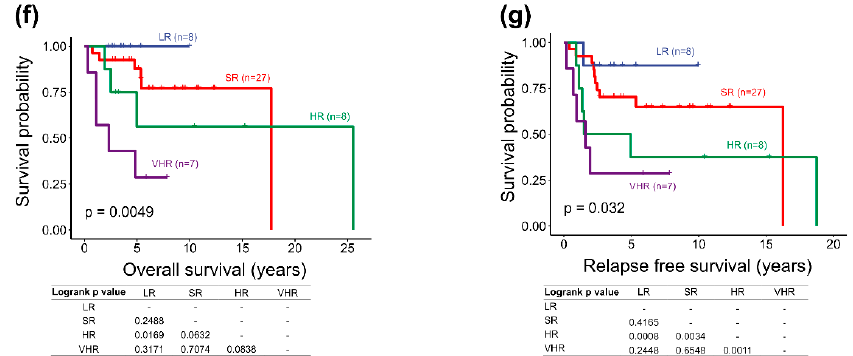
Figure 1. Outcome analysis of 52 childhood Medulloblastomas (MBs) in a cohort series in Taiwan. ( a ) Outcome analysis split based on overall survival (OS) (red) and relapse-free survival (RFS) (blue). ( b , c ) OS and RFS split into four core molecular subgroups: blue, WNT MB; green, Group 4 MB; red, SHH MB; yellow, Group 3 MB. ( b ) OS. ( c ) RFS). ( d , e ) OS and RFS split into three subgroups of molecular subgroup-based clinical risk stratification: blue, Non-met average risk (AR); red, Non-met high-risk (HR); and green, Met HR. ( f , g ) Survival analysis of the adjusted Heidelberg Scheme in childhood MBs of all ages split into blue, low-risk (LR); red, standard-risk (SR); green, high-risk (HR), and purple (very HR). ( f ) OS. ( g ) RFS. Table 1. Demography, molecular subgroup, clinical data, and molecular-clinical correlation in our cohort series of 52 childhood Medulloblastomas (MBs) in Taiwan. Molecular Subgroup